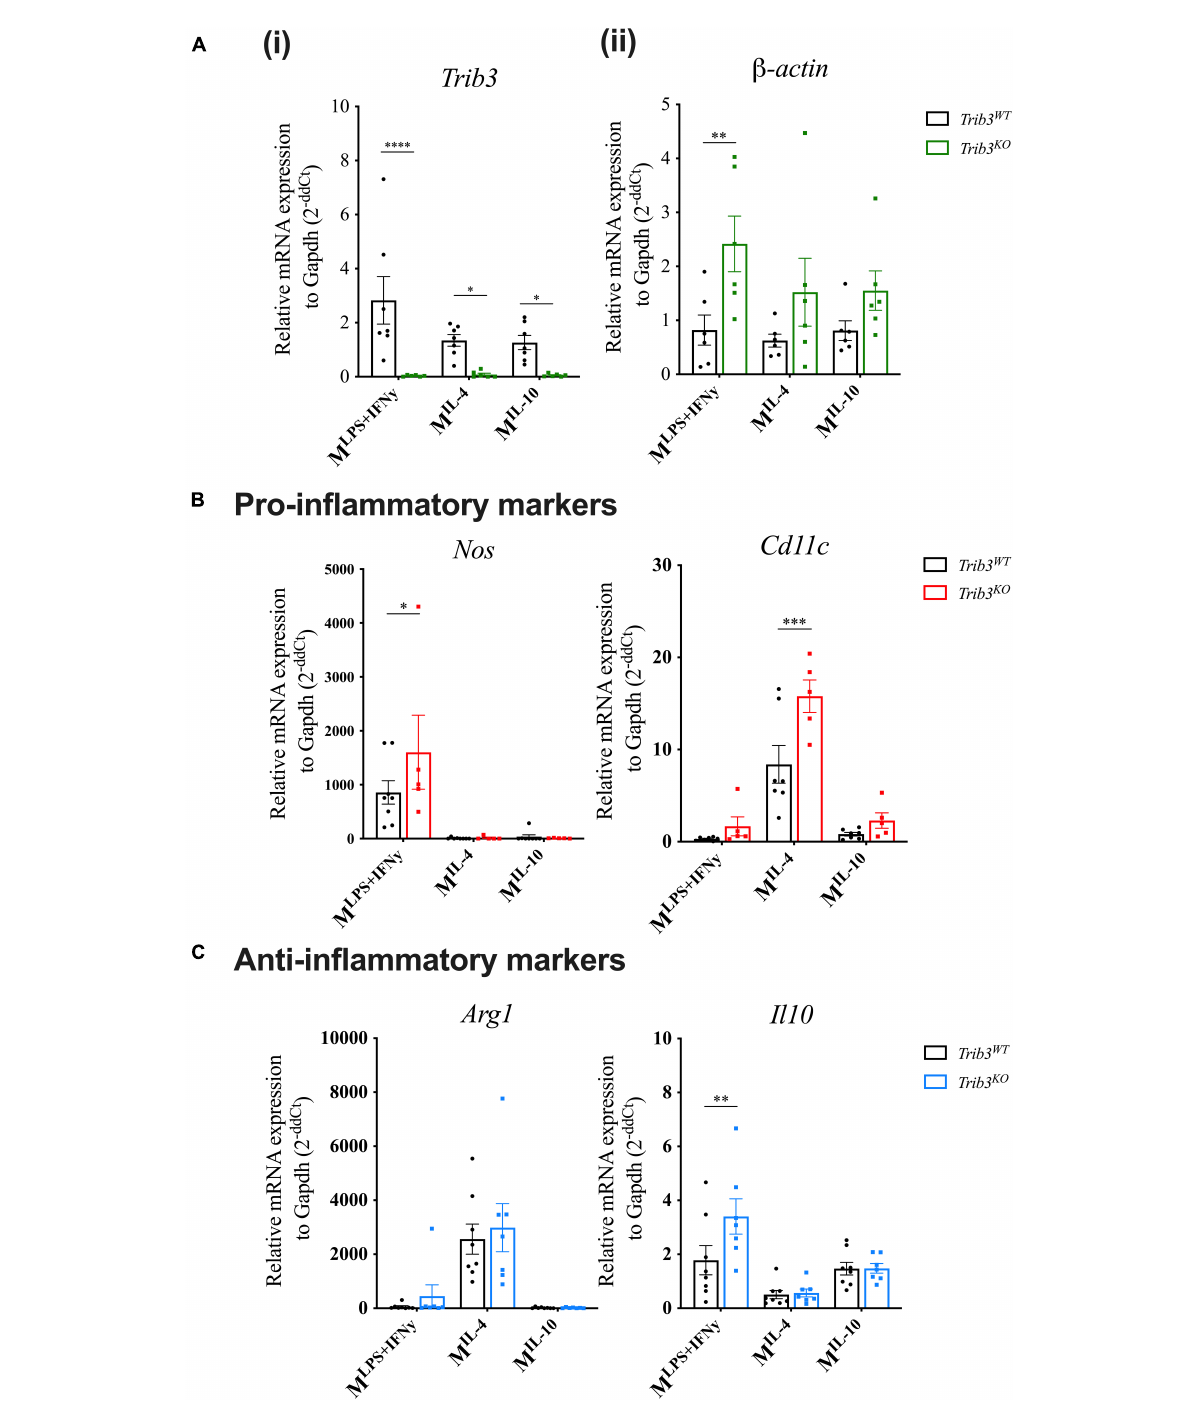
FIGURE7 Trib3 KO BMDMs show altered gene expression after polarisation. qPCR gene expression analysis after macrophage polarisation shows changes in the expression levels of (Ai) Trib3 to confirm the knockout genotype, (ii) β -actin for changes in the cytoskeleton, (B) and pro-inflammatory markers ( Nos2 and Cd11c) and (C) anti-inflammatory markers Arg1 and Il - 10 . Gapdh expression was used as an internal control and normalised to unpolarised controls to give 2 − (cid:49)(cid:49) Ct values. Graphs are presented as Mean ± SEM, two-way ANOVA with Fisher’s post hoc comparisons, ∗ p < 0.05, ∗∗ p < 0.01, ∗∗∗ p < 0.001, ∗∗∗∗ p <